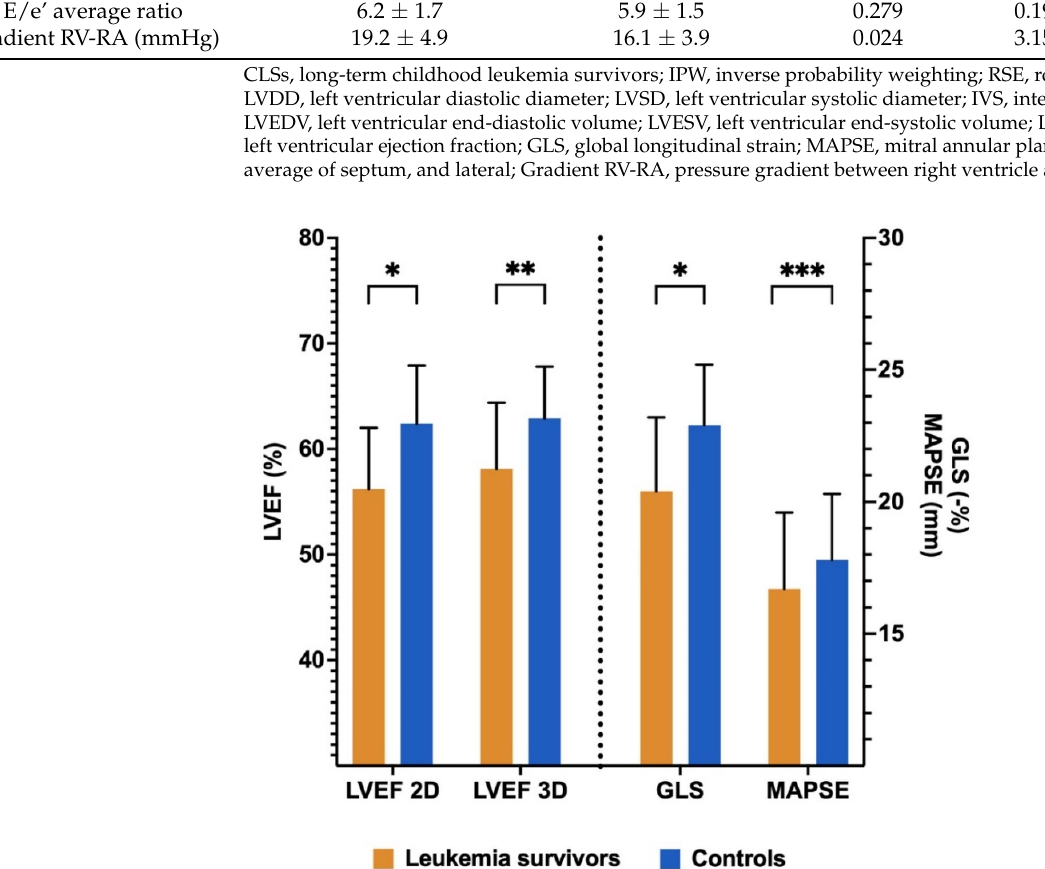
Univariable and multivariable linear regression models are shown in Table 3. The predictors of LVEF in the univariable analysis were time since diagnosis, hypertension, diabetes mellitus, anthracycline dose, radiotherapy, HSCT, and Hs-cTnI. In the multi- variable model, independent predictors of LVEF were diabetes mellitus, anthracycline dose >250 mg/m 2 , and